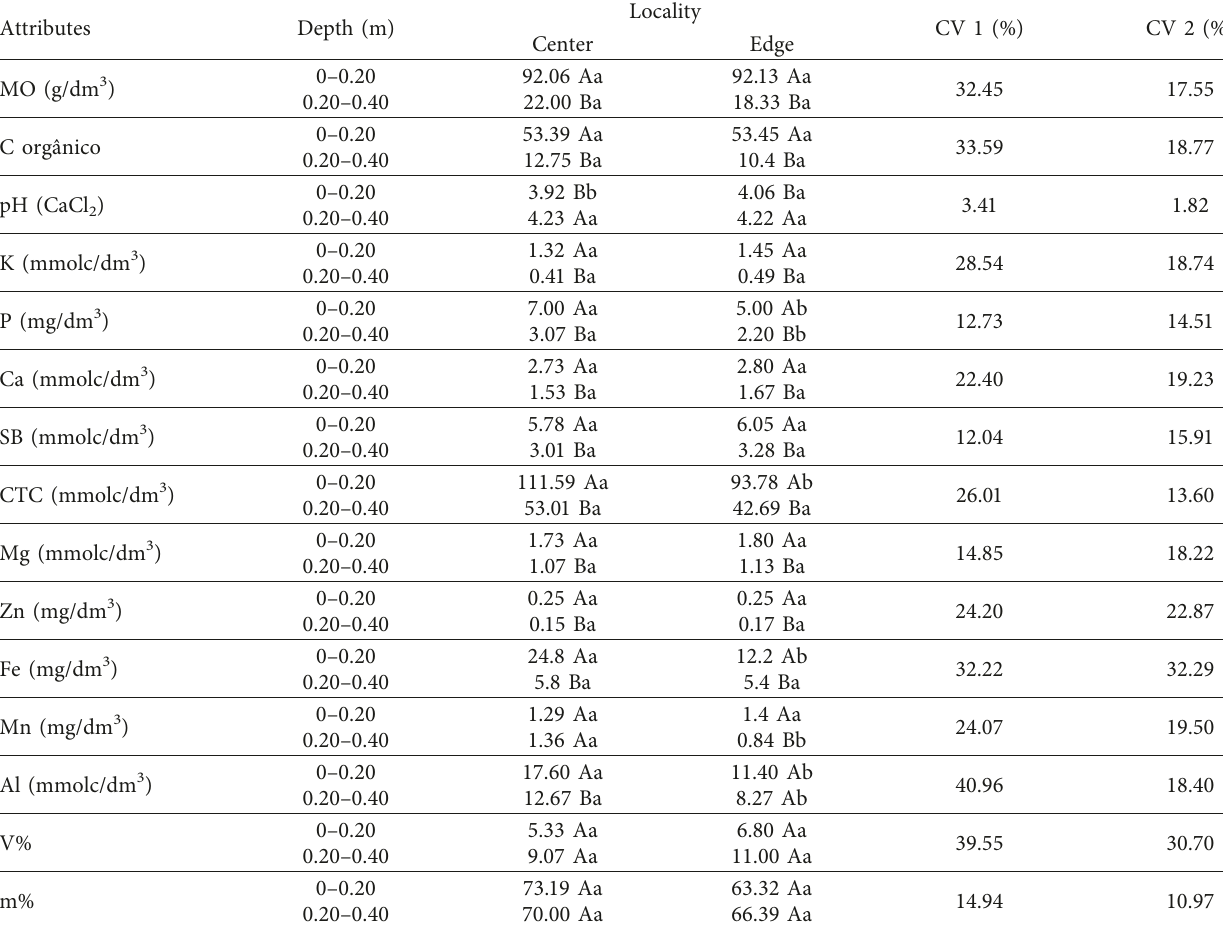
Table 2: Chemical attributes of the Ipucas soils, within the localities and depths